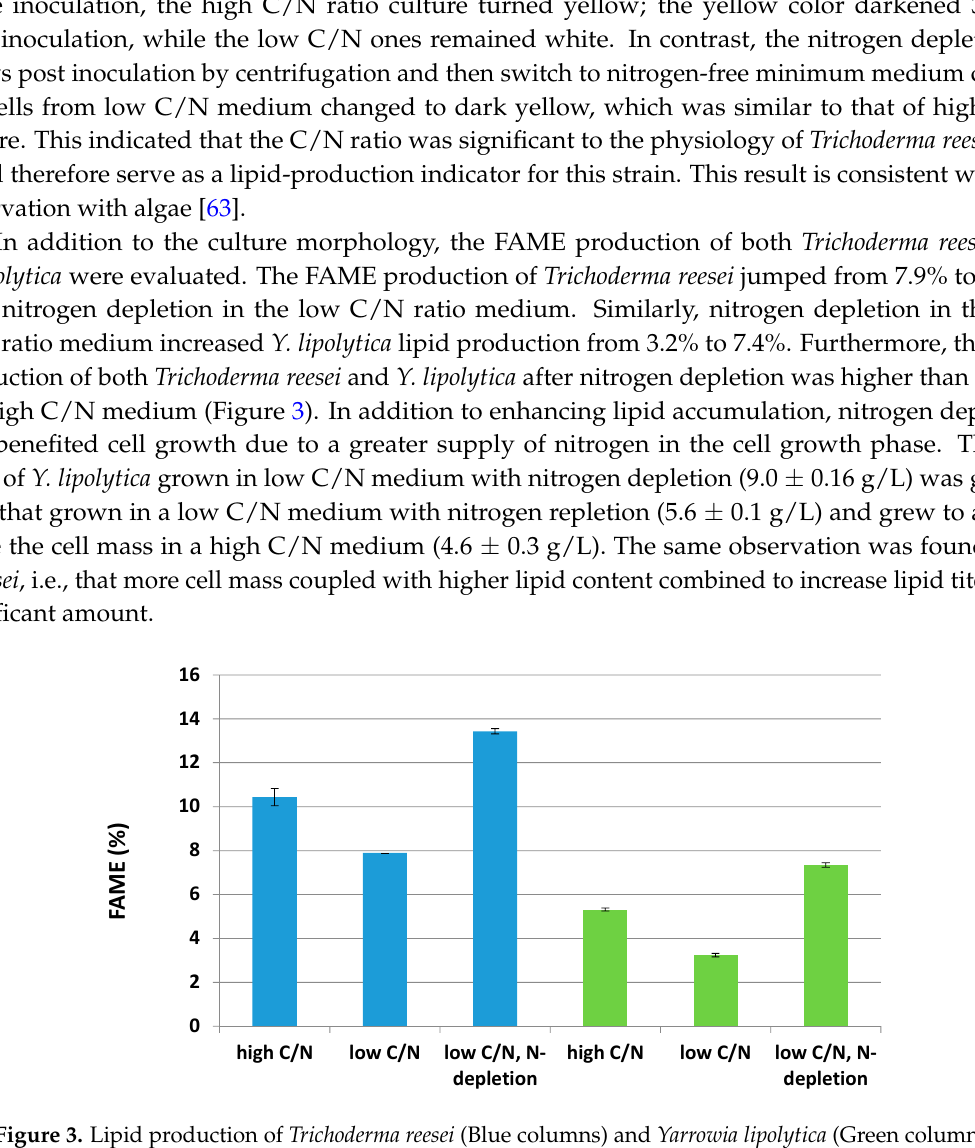
Figure 3. Lipid production of Trichoderma reesei (Blue columns) and Yarrowia lipolytica (Green columns) in different minimum media with a high C/N ratio, low a C/N ratio, and a low C/N ratio with nitrogen depletion, respectively. Data show mean value with standard deviation from technical triplicate samples of one representative experiment. The difference among three conditions in each species is significant based on One Way Analysis of Variance (ANOVA) with p-value less than 0.001 for all comparisons.